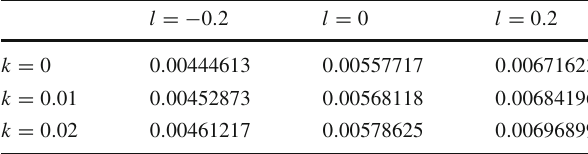
Table 1 Deviation δ s for Kerr-Sen-like black hole with a = 0 . 2